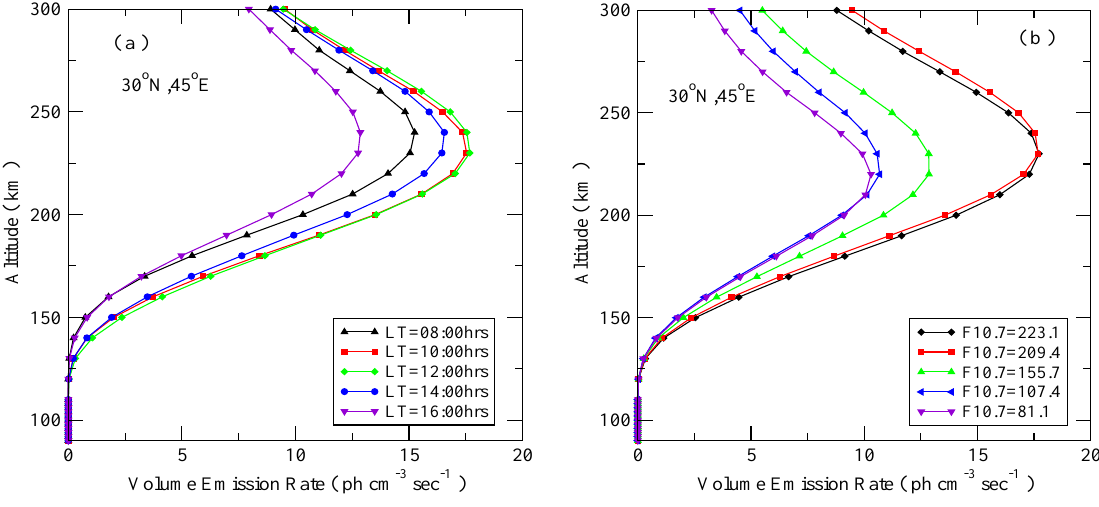
Fig. 2. Diurnal variation of the Volume Emission Rate (VER) of 7320 ˚A dayglow emission on 3 April 2002 (a) . Variation of VER of 7320 ˚A on 3 April at 30 ◦ N 45 ◦ E with F10.7 solar index (b)